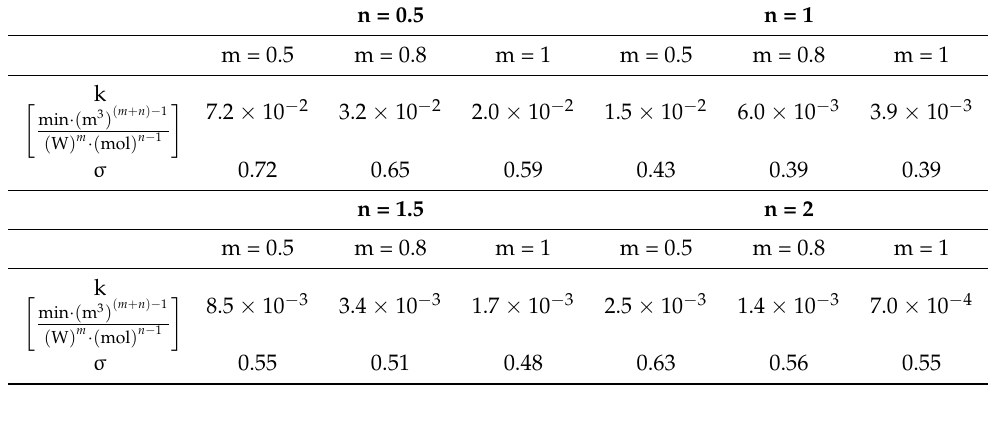
Table 2. Kinetic constants and standard deviations for different sets of m and n parameters.